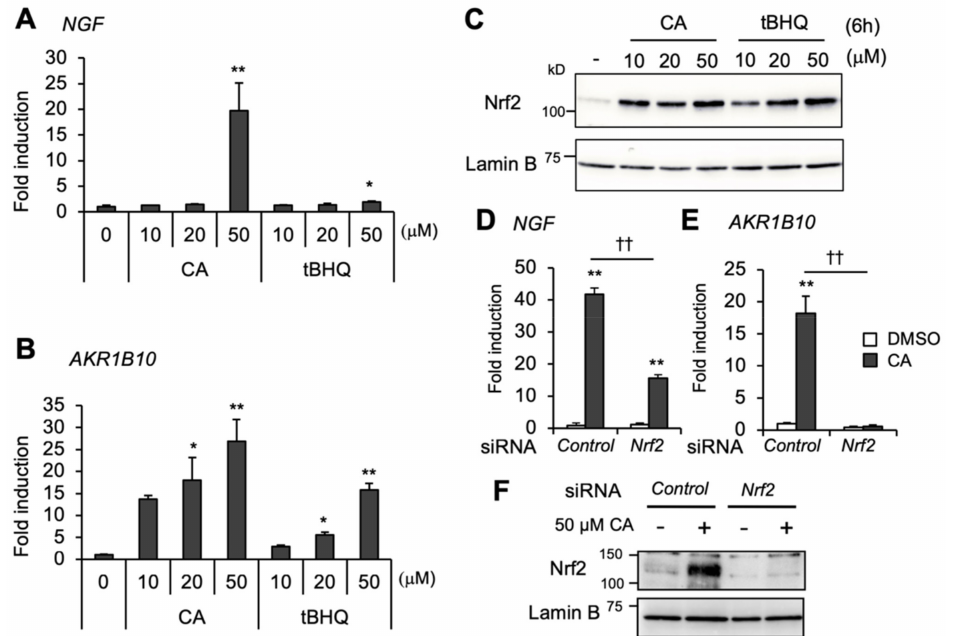
Figure 1. High-dose CA regulates NGF gene expression beyond Nrf2 activation. CA and